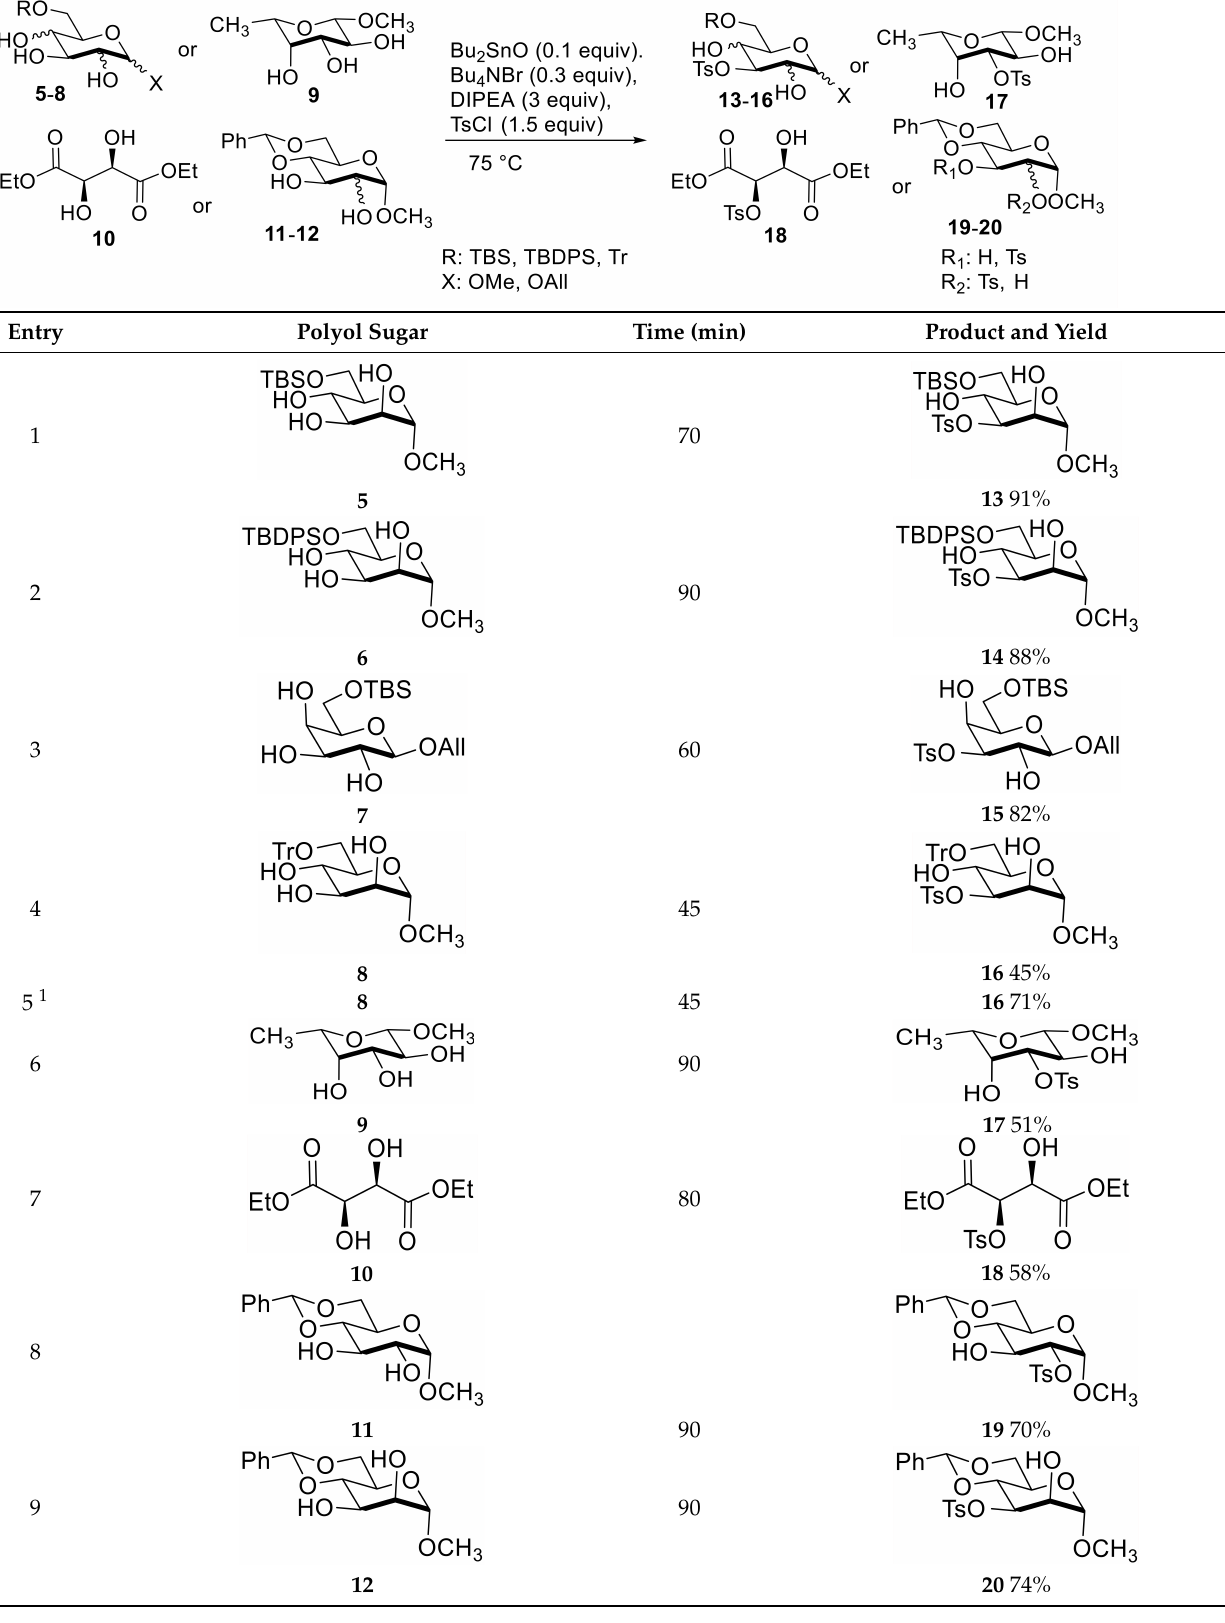
Table 2. Regioselective tosylations of sugars protected at primary